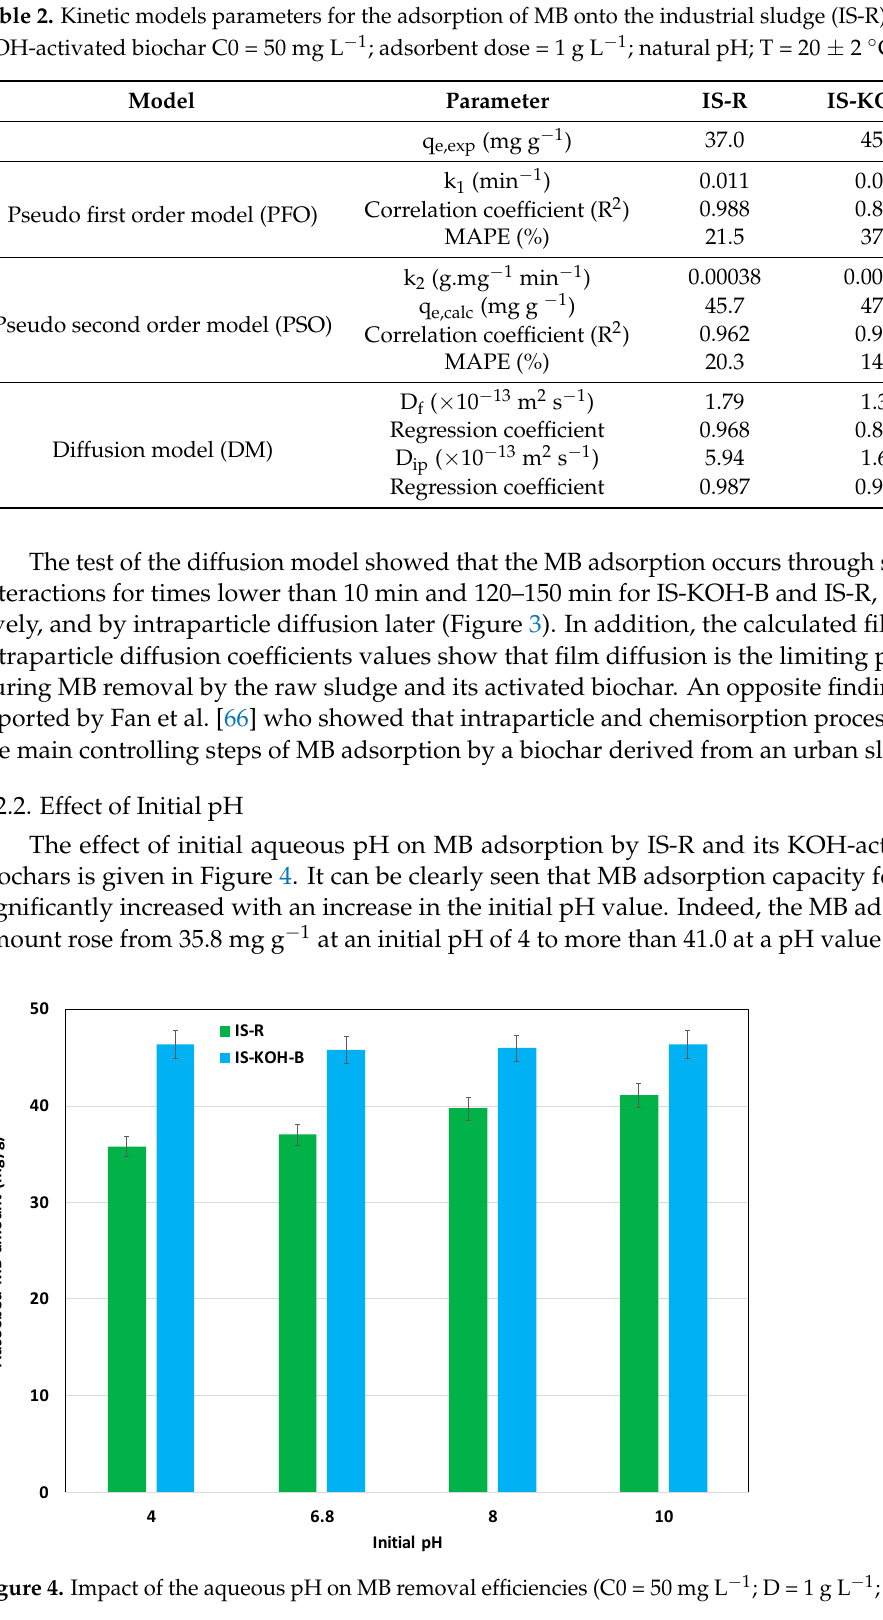
Table 2. Kinetic models parameters for the adsorption of MB onto the industrial sludge (IS-R) and its